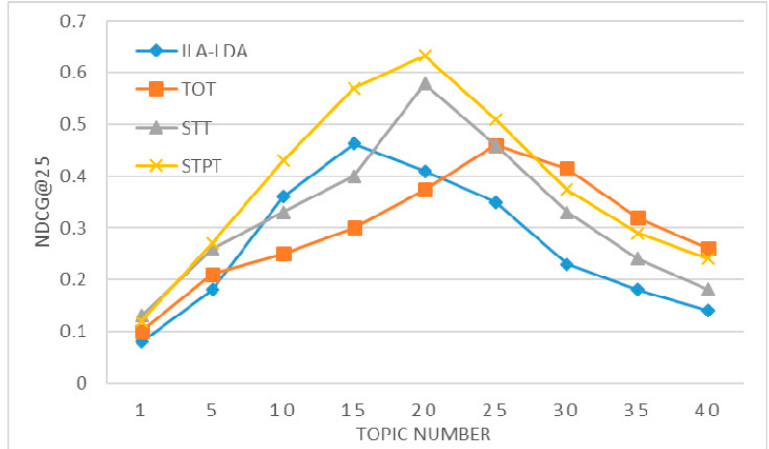
Figure 11. The NDCG values of the recommendation models for different task numbers.